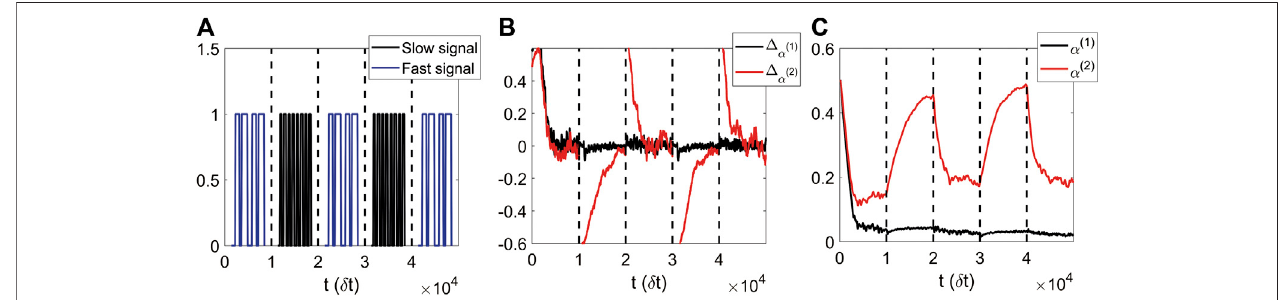
FIGURE 5| The online training ofthe leakage terms can adapt to the changing environment, that isthe signal probabilities are increased or decreased periodically. (A) :Schemeofthechangeofthevaluesofprobabilities,wherehighprobabilitiesofswitchingarereferredtoasfastphaseofthetelegraphprocess,whilelowprobabilities as slow phase. (B) : Running average of the gradients of α ( 1 ) and α ( 2 ) as time varies. (C) : Online adaptation of the leakage